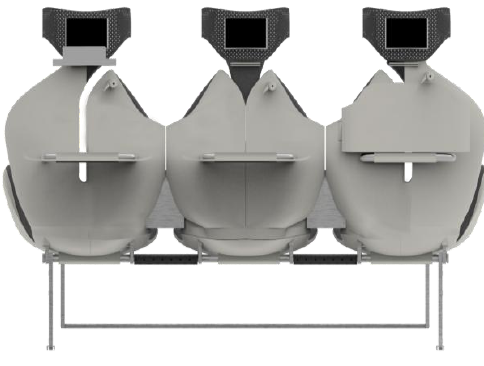
Figure 42. Back view of final product.